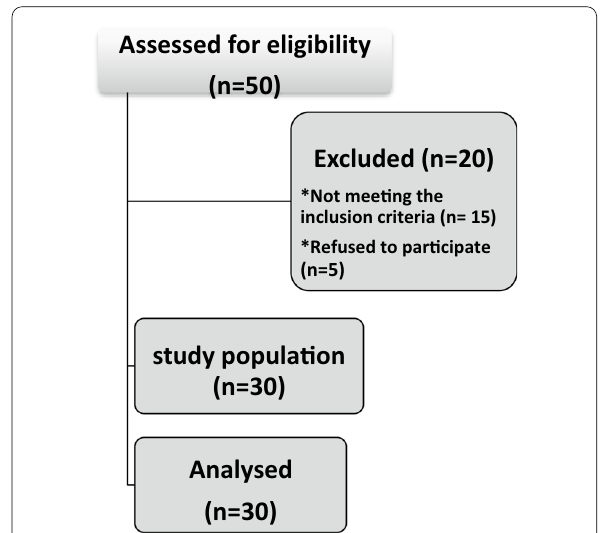
Fig. 1 Flow chart of the